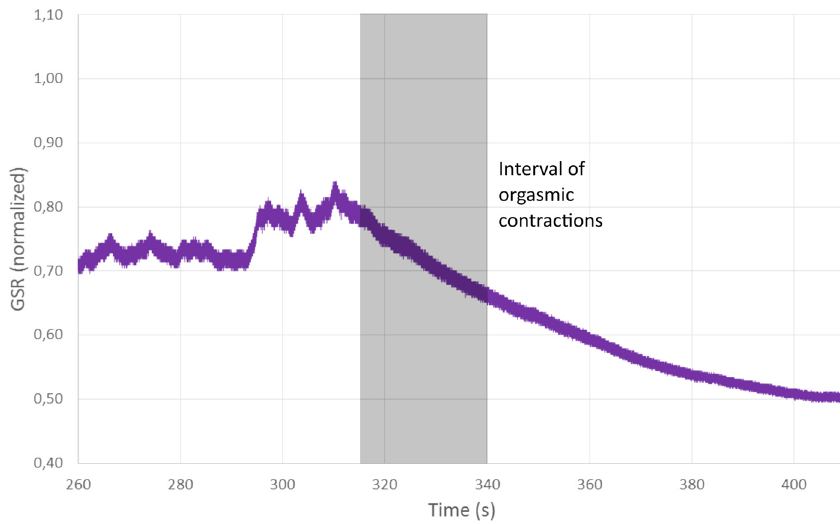
Figure 31: GSR recorded during masturbation and